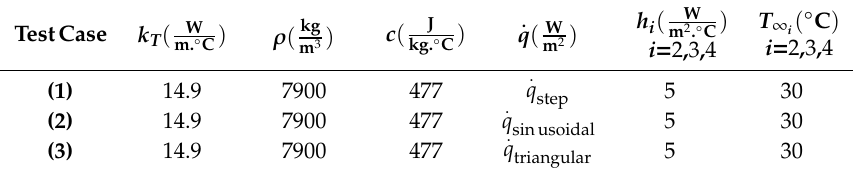
t . Figure 2. The place of the sensor S , S i